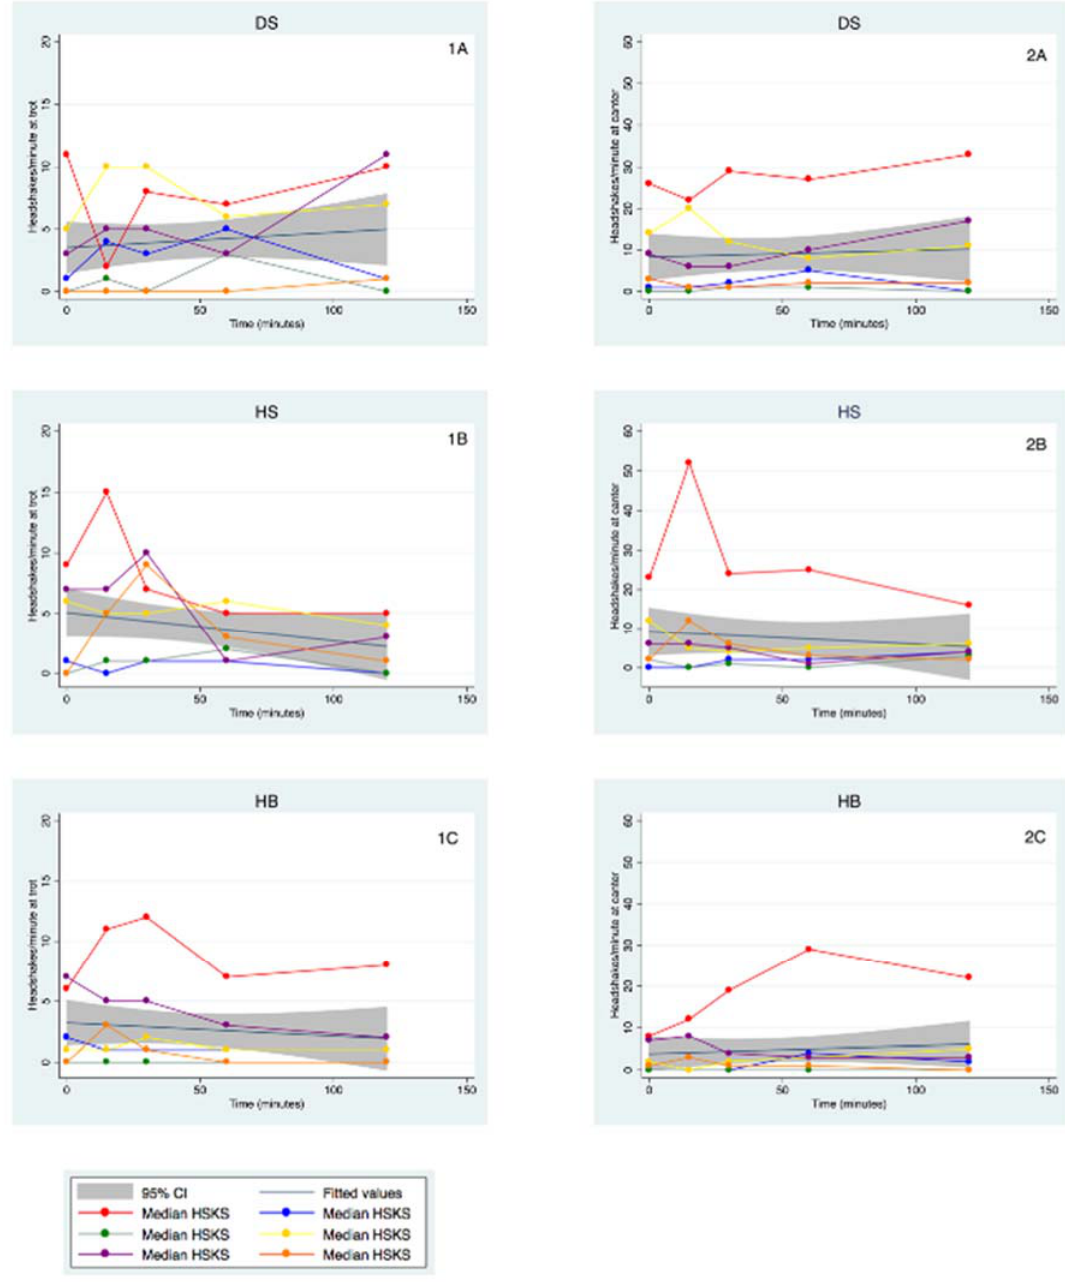
Figure 1. Headshaking behavior for individual horses and overall change over time (Graphs 1A – C ) at the trot; (Graphs 2A – C ) at the canter. Each horse is displayed as a different color and the overall change in headshaking behavior is represented by the regression line. Top graphs ( 1A and 2A ) = DS (5% dextrose solution at 2 mL/kg bwt), middle graphs ( 1B and 2B ) = HS (NaCl 7.5% solution at 4 mL/kg bwt), and bottom graphs ( 1C and 2C ) = HB (NaHCO 3 8.4% solution at 2 mmol/kg bwt).